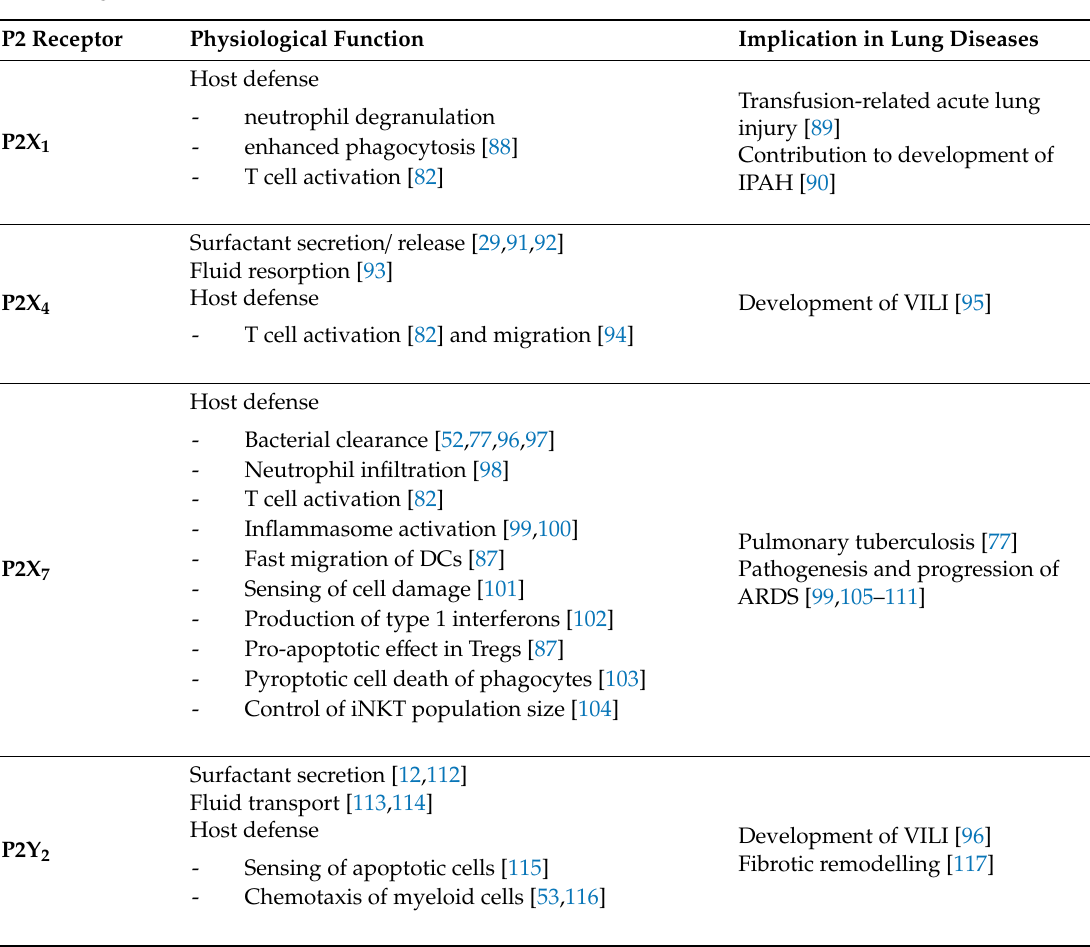
Table 2. Contribution of P2 receptor signaling to alveolar function and to the development / progression of lung